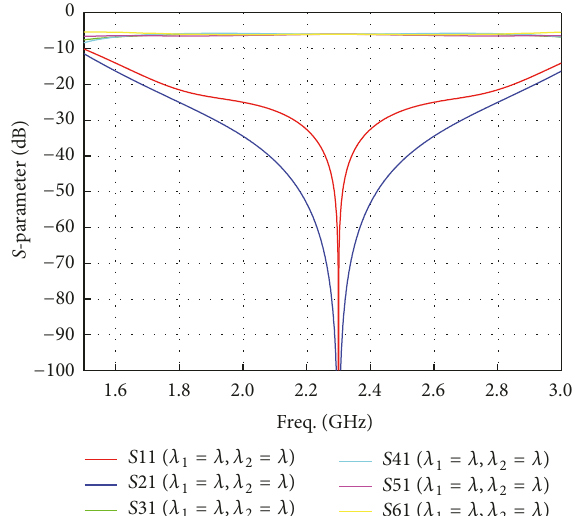
Figure 4: 𝑆 -parameters of the hybrid feeding network with equal half-wavelength delay lines of Port 1 and Port 2.